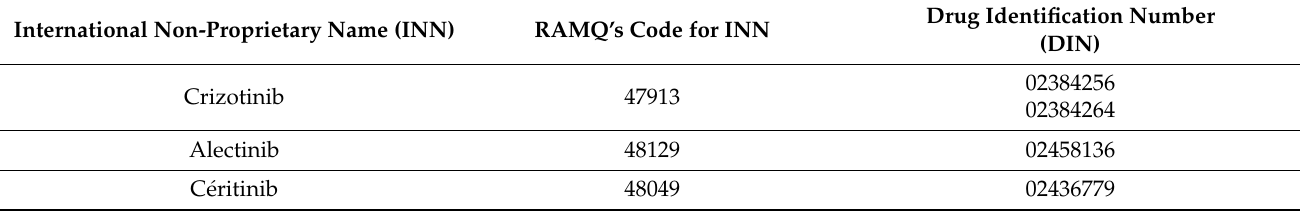
Table A3. International Non-Proprietary Names and Drug Identification Numbers of